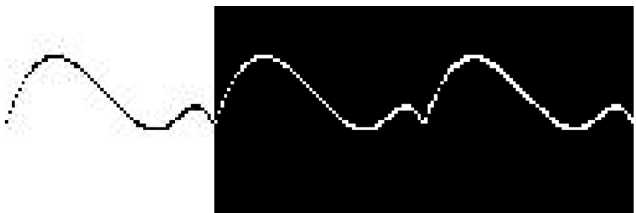
P ERFORMANCE OF THE SSN T RAINED FOR 150 E POCHS BY F IG . 5 Fig. 9. The test instance (the test image versus truth and segmented images) W ITHOUT D ROP O UT segmented worst by the deeper SSN (Fig. 5) without DropOut trained for 150 epochs (whose performance indicators are presented in Table III). Visually, the erroneously segmented pixels (or non-segmented interior pixels) are hardly noticed. The region is too narrow, though (appearing roughly just as a one-pixel line rather than a region or stripe having some interior space).